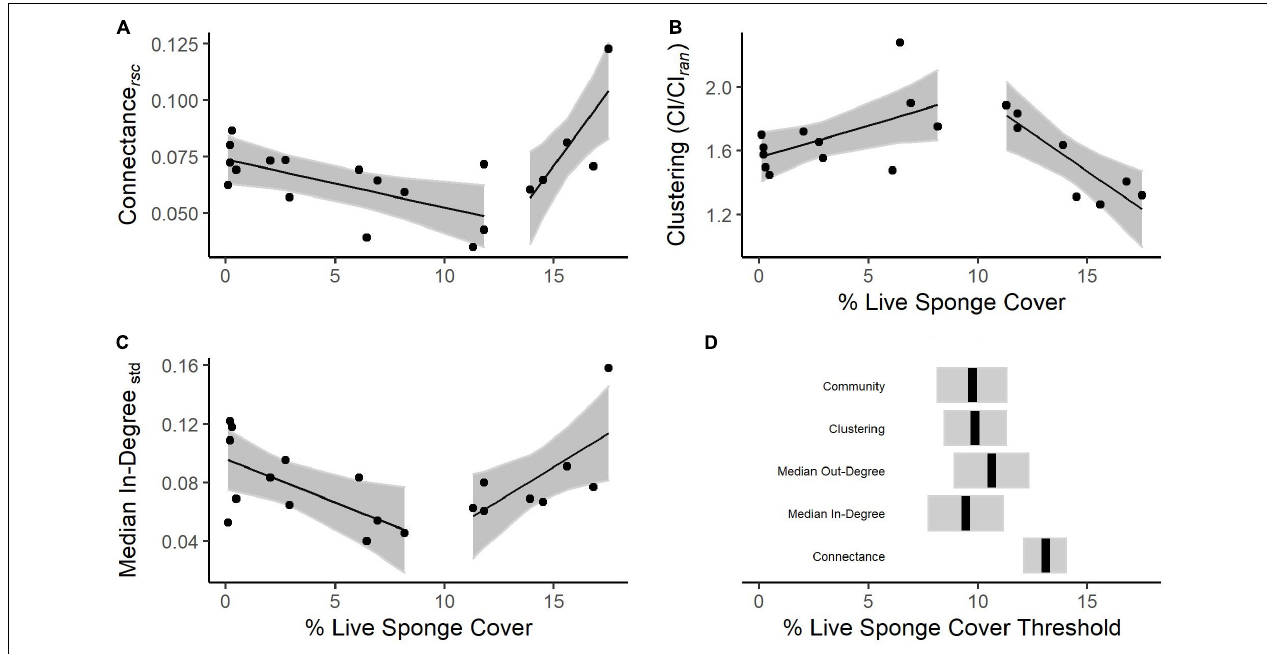
FIGURE 5 | Food web topological metrics related to percent cover of live reef-building sponge: (A) re-scaled connectance, (B) the ratio of observed to random clustering coefficients, and (C) median In-Degree standardized by the total number of possible incoming links. The lines are the result of piecewise linear regression and the shaded areas represent the 95% confidence intervals (CIs). In panel (D) we show the estimated threshold, or change point, for each index that demonstrated this behavior. The shaded area represents 95% CIs, except in the case of the community threshold where it represents 95% empirical quantile estimates.